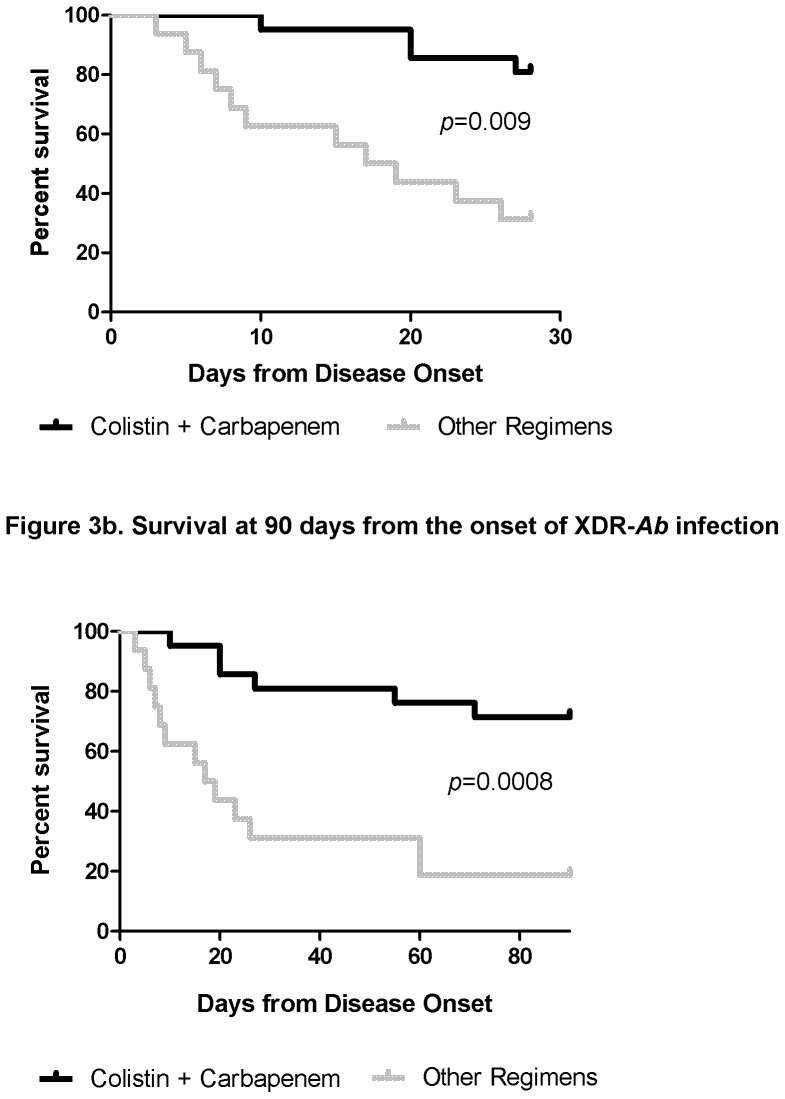

Figures 3a and 3b
 provide Kaplan-Meier curves comparing 28 and 90-day survival, respectively.The graphs compare colistin-carbapenem regimens to other treatment regimens.